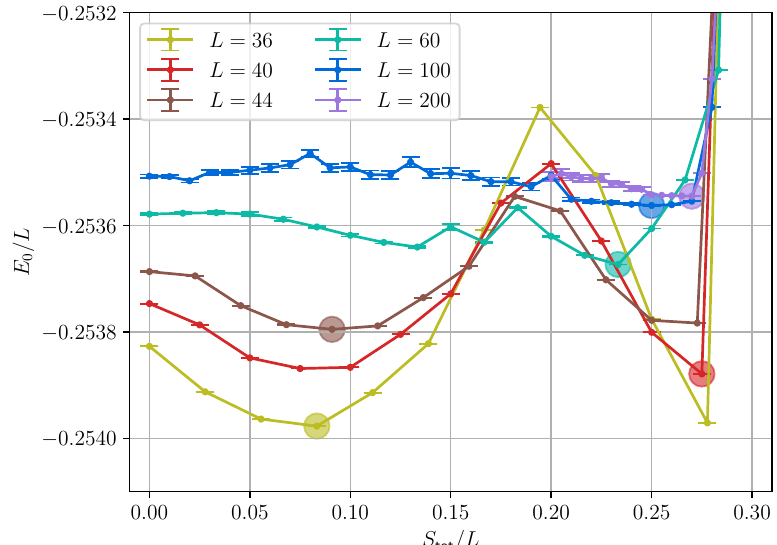
Figure 5: The same as in Fig. 2, but for J ′ / | J | ≈ 1.3 and different system sizes L . The circle marks the absolute minimum. It is evident that small systems waver between two minima before eventually settling in the high-spin minimum, cf. the orange line in Fig.